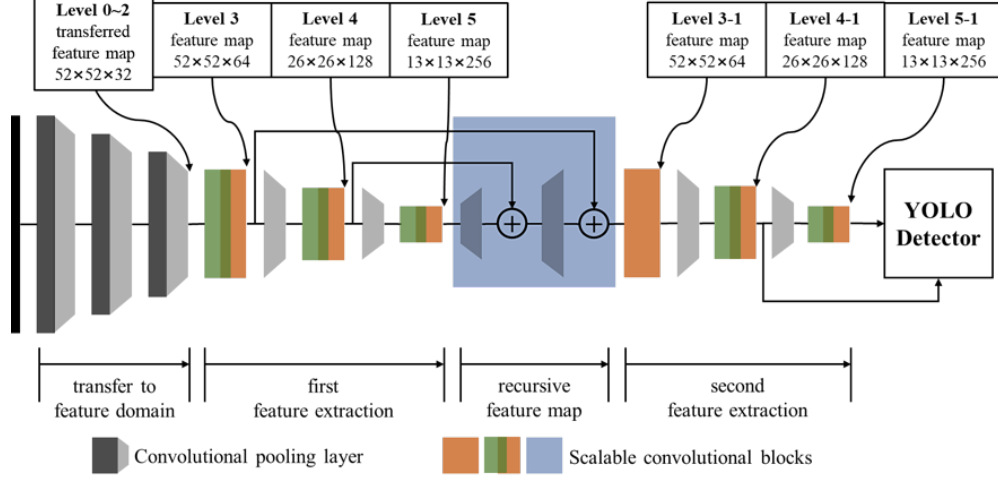
Figure 4. Block diagram of SF-YOLO (medium) architecture.